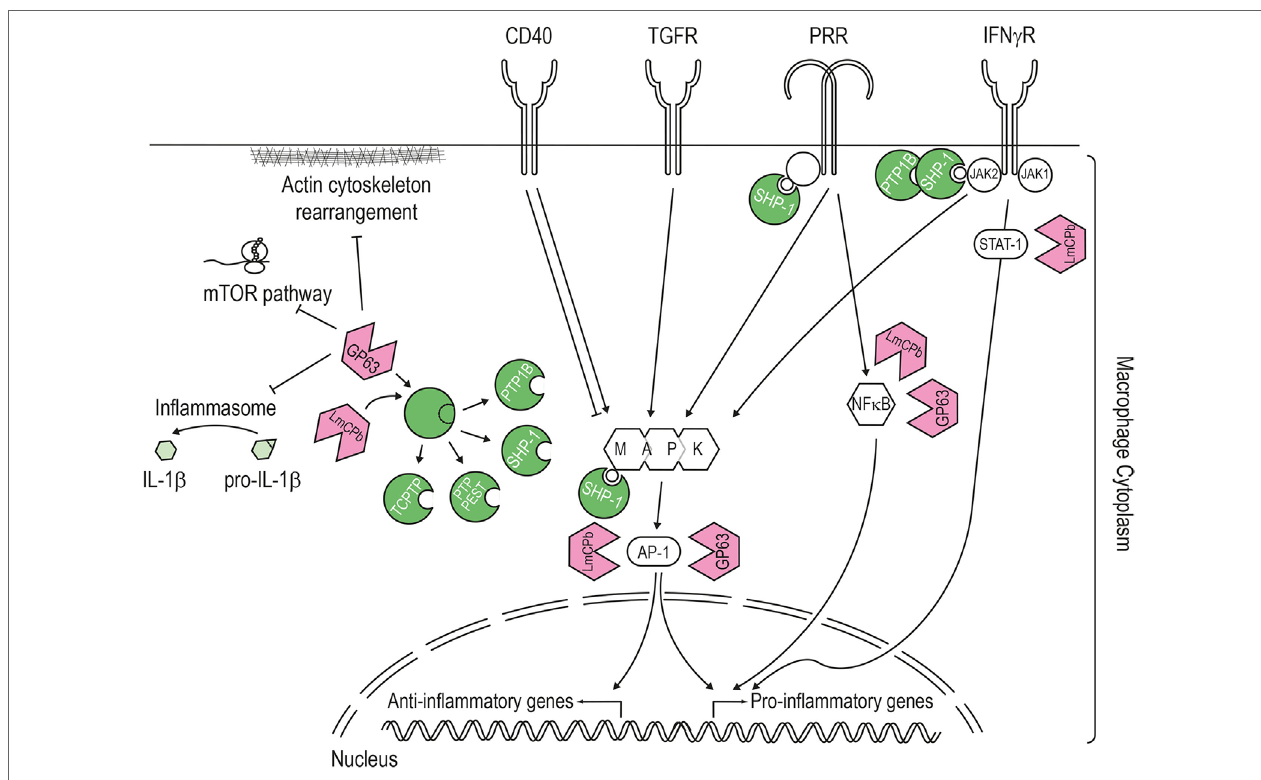
FigURe 3 | Pathways targeted by the Leishmania virulence factors. LmCPb and GP63 proteases are Leishmania virulence factors secreted via the exosome route and found inside the host cell cytoplasm where they can alter numerous signaling pathways. The best studied Leishmania protease is GP63, which proteolytically cleaves and activates host phosphatases (such as PTP1B, PTP-PEST, TCPTP, and SHP-1) or the NF- κ B subunit p65/RelA. Once activated, SHP-1 downregulates the macrophage response to interferon- γ by interacting with the kinase JAK2, modulates the pathways induced by pathogen recognition receptors (e.g., toll-like and lectin receptor) and also targets signaling kinases such as mitogen-activated protein kinase. In addition, Leishmania proteases contribute to this general downregulation of the host cell response by degrading proteins of the actin cytoskeleton, mTOR (leading to repression of host cell translation), transcription factors (like STAT1 or AP-1), and components of the NLPR3 inflammasome (thereby blocking the generation of IL-1 β